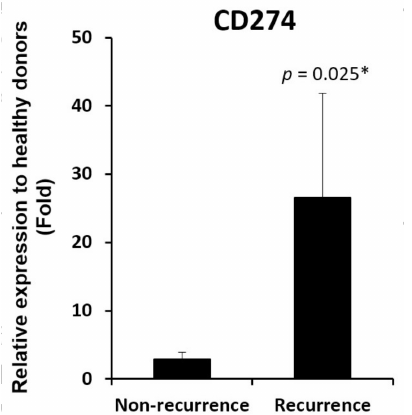
Figure 3. HFE down-regulation in liver grafts from recipients with post-transplant HCC recurrence. RT-qPCR result demonstrated a down-regulation of HFE , but not ITGA8 and SELE , in liver grafts from recipients with post-transplant HCC recurrence. ** p < 0.01.